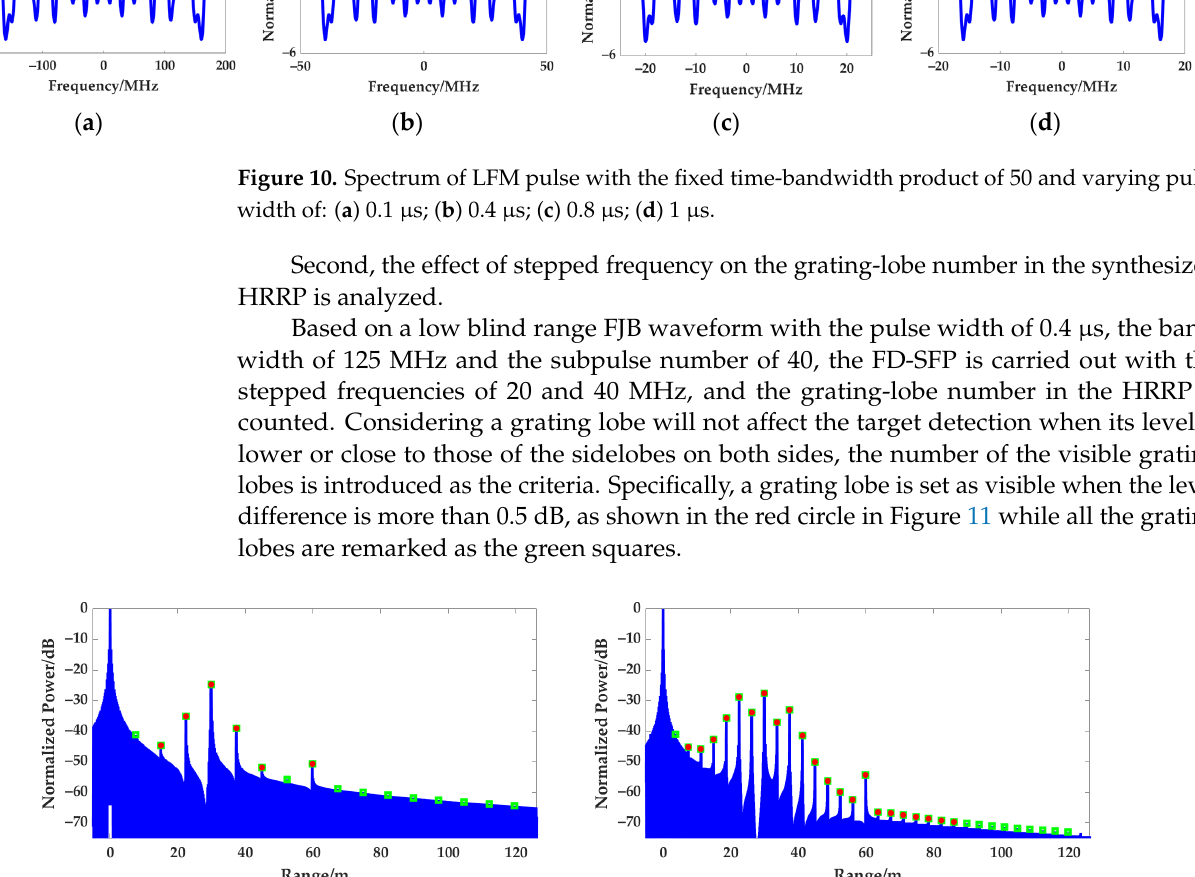
( b ) Figure 12. Simulation results of the effect of step frequency on visible grating lobes: ( a ) relationship between the number of the visible grating lobes and step frequency; ( b ) relationship between the levels of the visible grating lobes and step frequency.